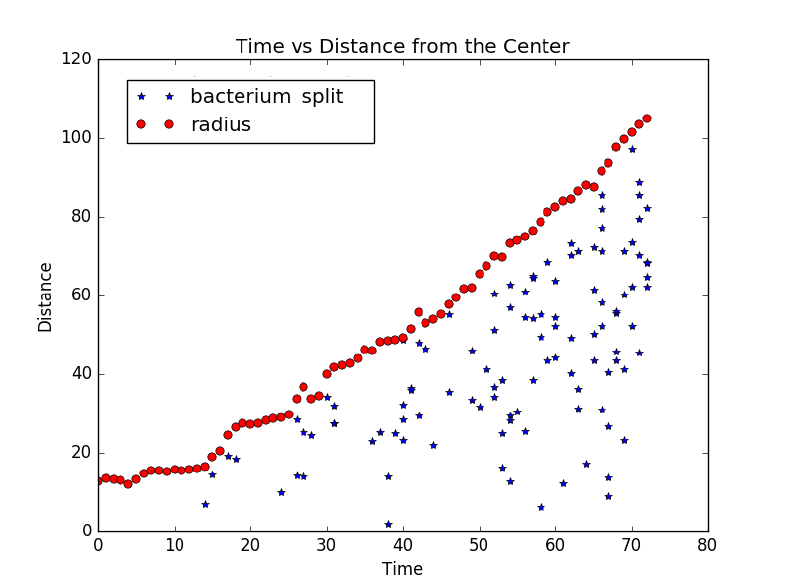
Figure 7. Scatter plot showing how far each bacterium was from the center of the image as a function of the time that it split. Red dots represent whichever bacterium is furthest from the center. Past frame 70 it can be seen that splitting is occurring at the periphery before it does closer to the center, because beyond frame 70 there are 12 splits occuring at 40 pixels or more from the center, and zero occurring closer than 40 pixels. Our detailed lineage tree tells us that the resulting daughter cells are in the 7th generation while those closer to the center are only in the 6th, suggesting bacteria near the periphery are are reproducing faster than those near the center—an observation that would be impossible without a correct, detailed family